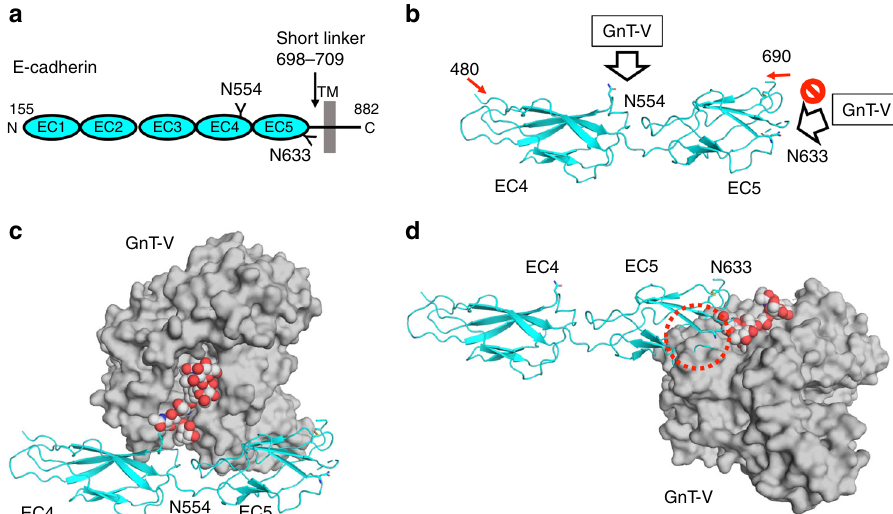
Fig. 6 Hypothetical interaction mode between GnT-V and E-cadherin. a Schematic representation of human E-cadherin. E-cadherin is a type I membrane protein and has fi ve ectodomains (EC1 – 5). Two N -glycans at N554 and N633 are highlighted. EC5 connects to transmembrane helix via short linker region (698-709). b Crystal structure of murine E-cadherin EC4-EC5 ectodomains (PDB code: 3Q2V 45 ) is shown in ribbon model. Two N -glycosylation sites, N554 and N633, are shown in rod models. c Docking models of GnT-V and N -glycan at N554 of E-cadherin EC4-EC5 ectodomain. GnT-V, N -glycan and E- cadherin are shown in surface, sphere and ribbon models, respectively. d Docking models of GnT-V and N -glycan at N633 of E-cadherin EC4-EC5 ectodomains. GnT-V, N -glycan and E-cadherin are shown in surface, sphere and ribbon models, respectively. Steric clash is indicated with red dotted circle. The three fi gures, b – d , are depicted from the same view